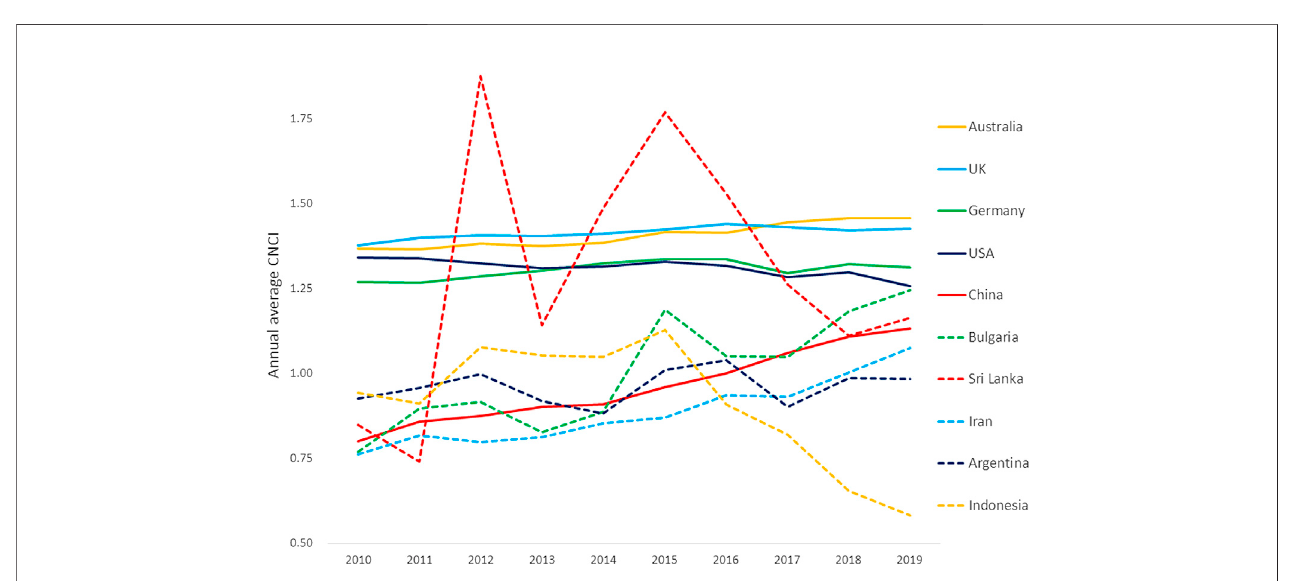
Figure 1 | Annual trends over the last decade in national Category Normalized Citation Impact (CNCI) for the ten countries summarized in Table 1 .